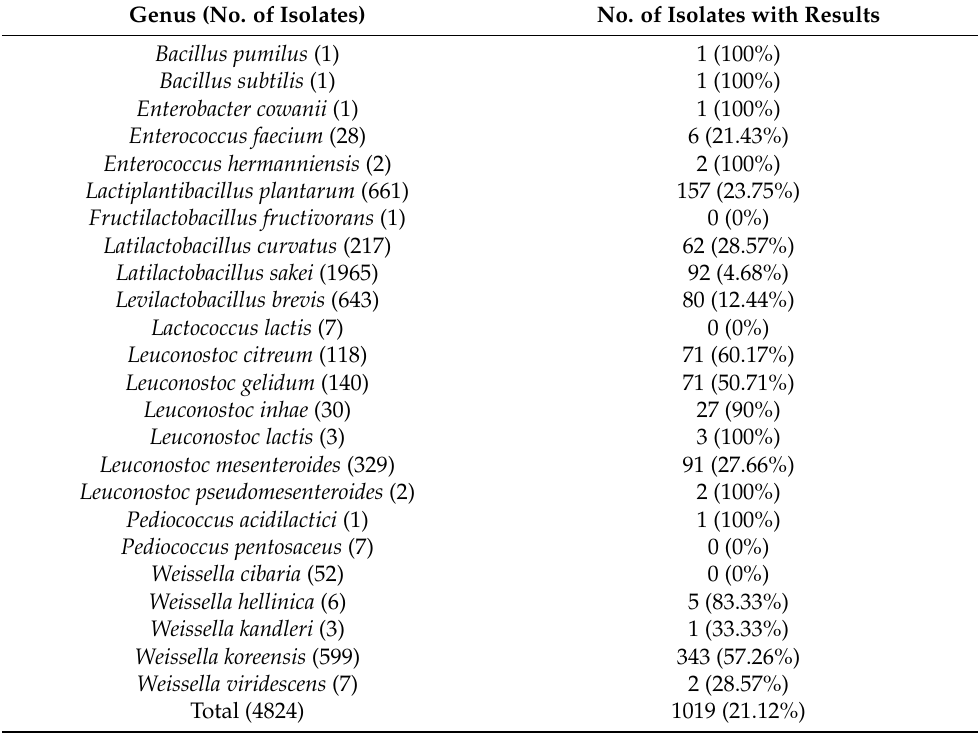
Table 2. Number of isolates with correct identification to the genus level by MALDI-TOF